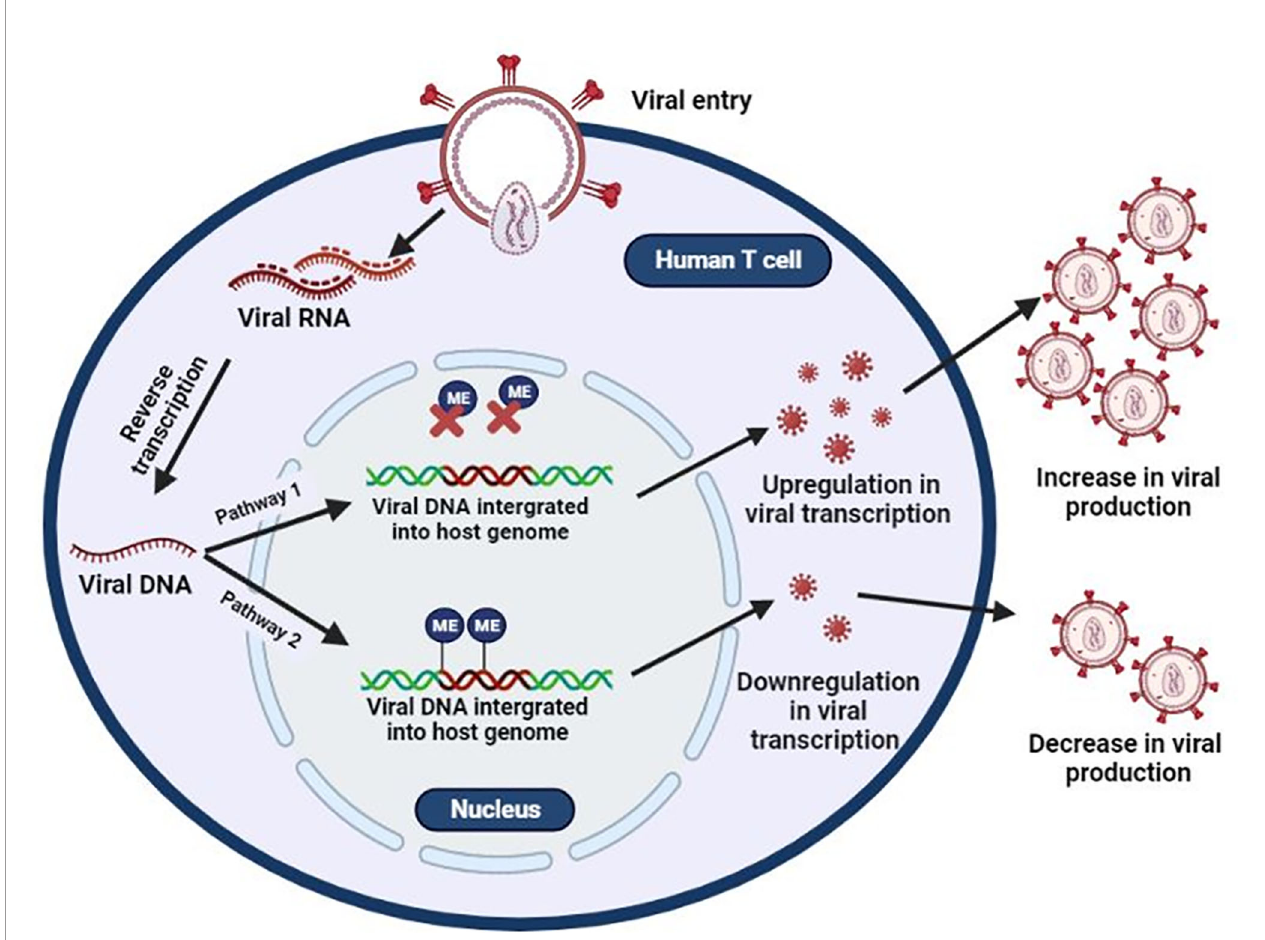
FIGURE 1 | Epigenetic silencing of HIV transcription via methylation of integrated provirus. HIV binds to host receptors, entering the cell. HIV viral RNA is converted to single-stranded viral DNA and integrates into the host genome. HIV uses the host ’ s machinery to create new HIV copies (Pathway 1). However, methylation of integrated provirus results in the downregulation of HIV viral transcription, resulting in latency (Pathway